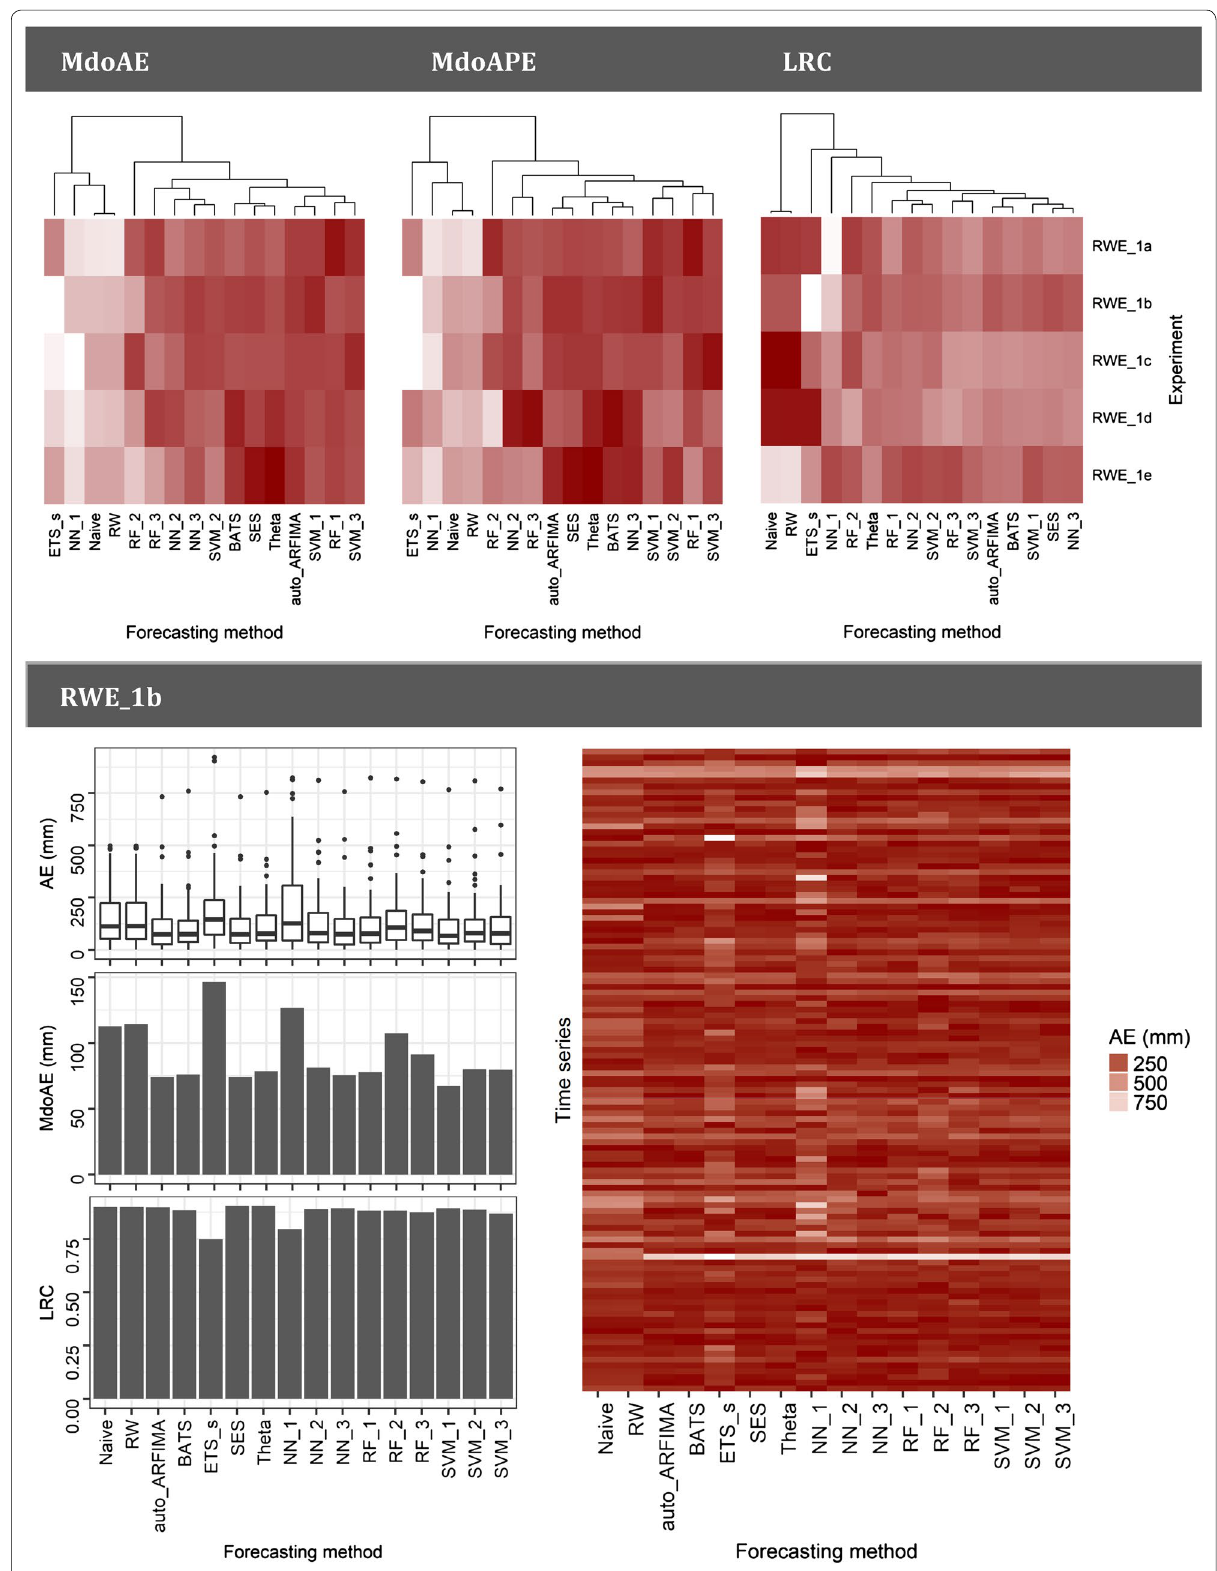
Fig. 2 Results in brief of the experiments using the PrecDat